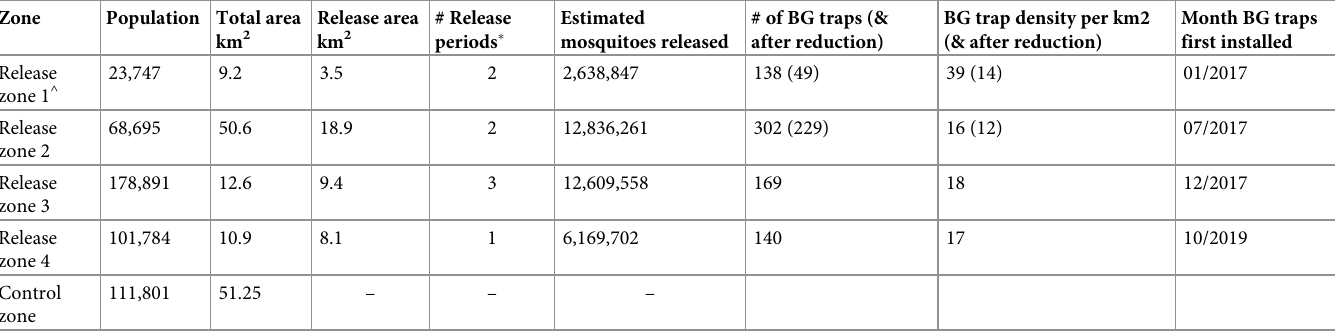
Table 1. Baseline characteristics and summary of w Mel releases and monitoring by